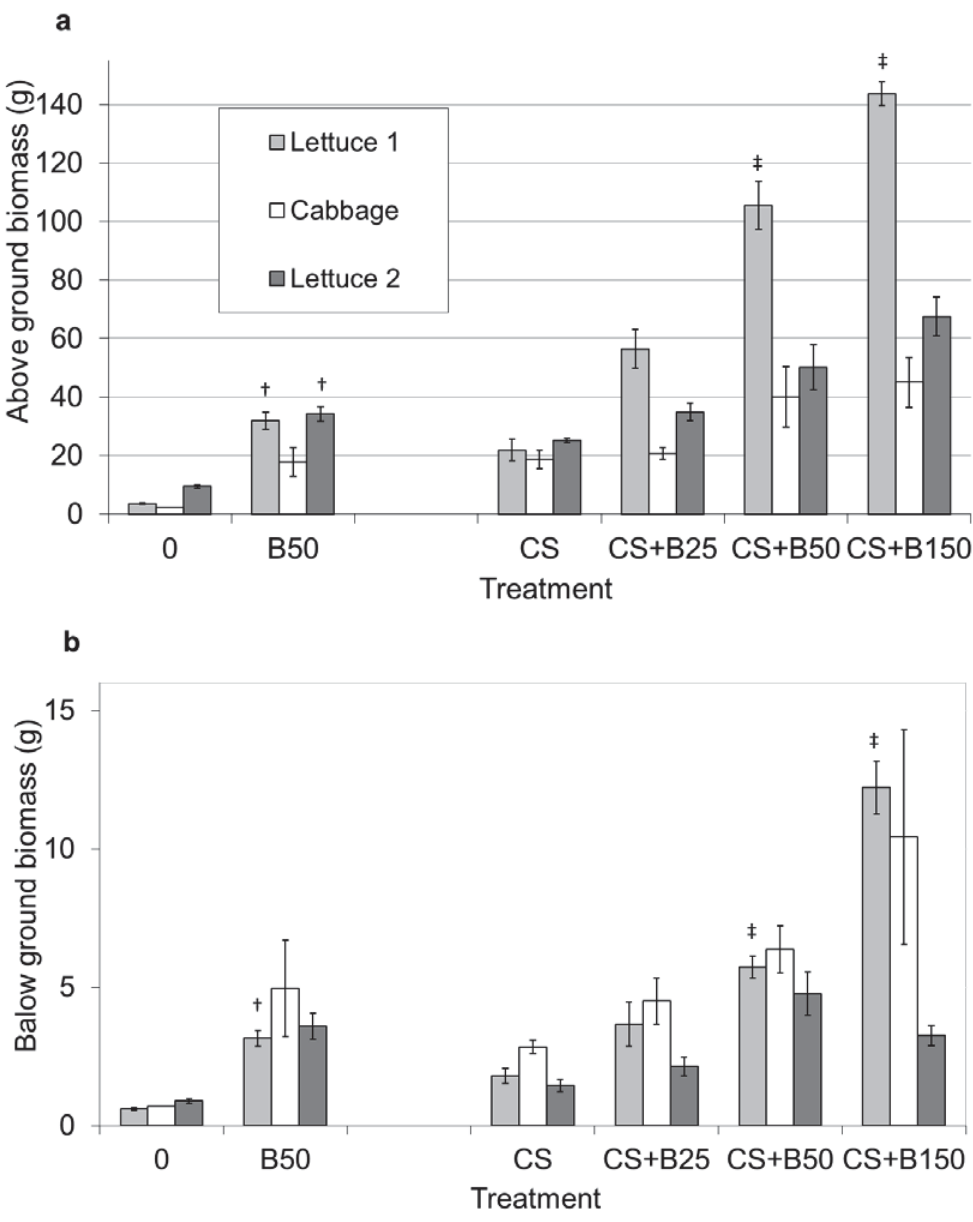
Figure 2. Lettuce crop 1, cabbage * and lettuce crop 2 in all treatments values and standard error across all cycles for ( a ) above ground biomass (g) ( b ) below ground biomass (g) ( c ) number of leaves ( d ) stem length (cm). † Significantly different from control “0” (treatment without CS only); ‡ significantly different from control CS (treatments with CS only) (ANOVA with post hoc Tamhane, (cid:545) <